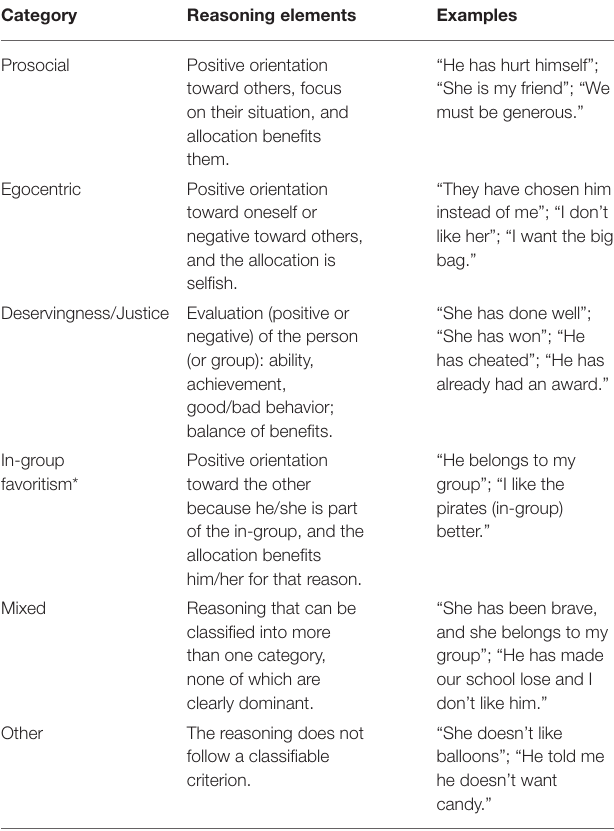
TABLE 7 | Response categories for the justification of the allocations (behavioral measure).